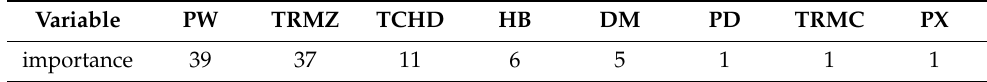
Table 9. Importance of variables for Chinese fir.